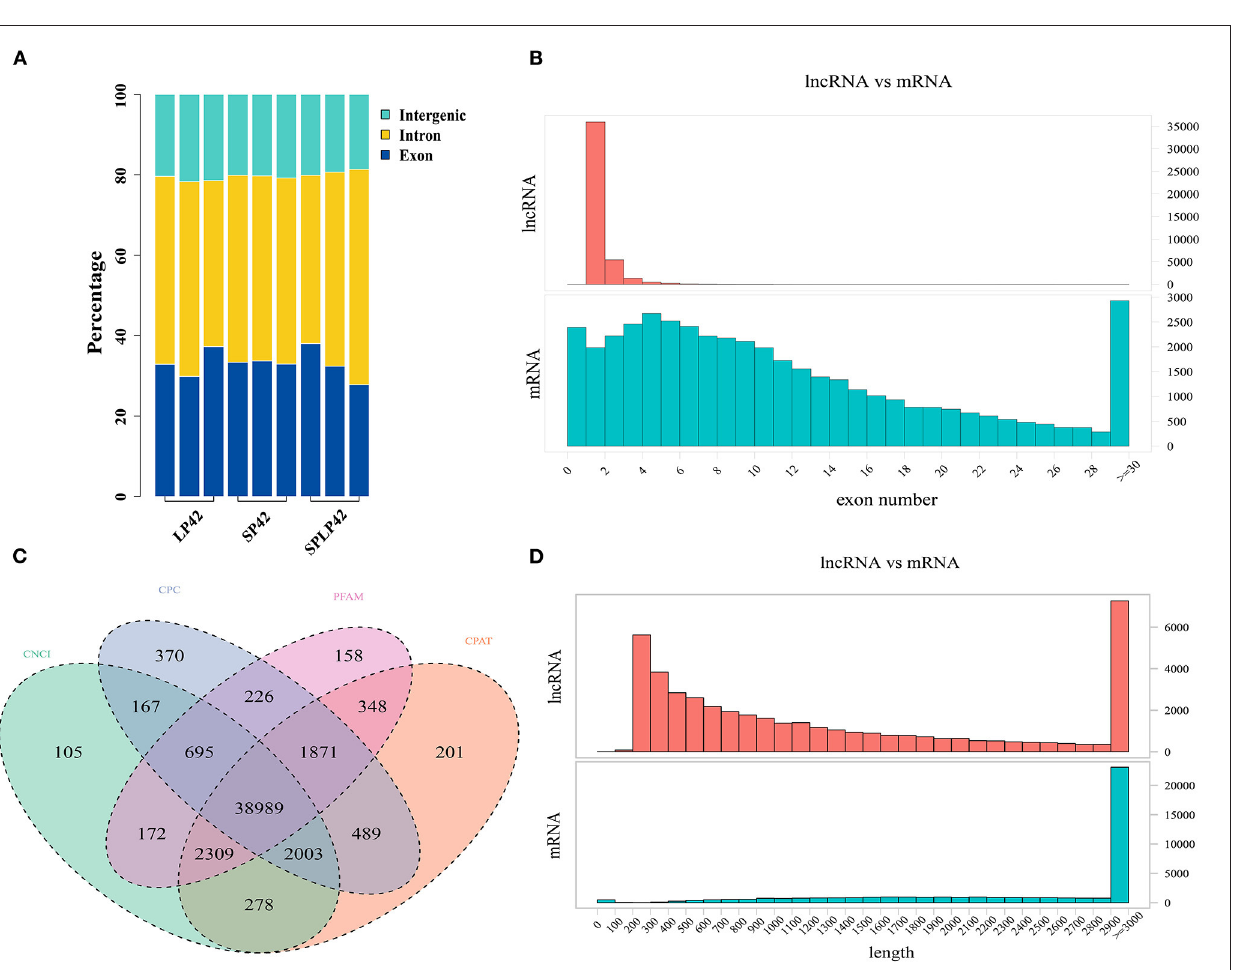
Frontiers in Veterinary Science |